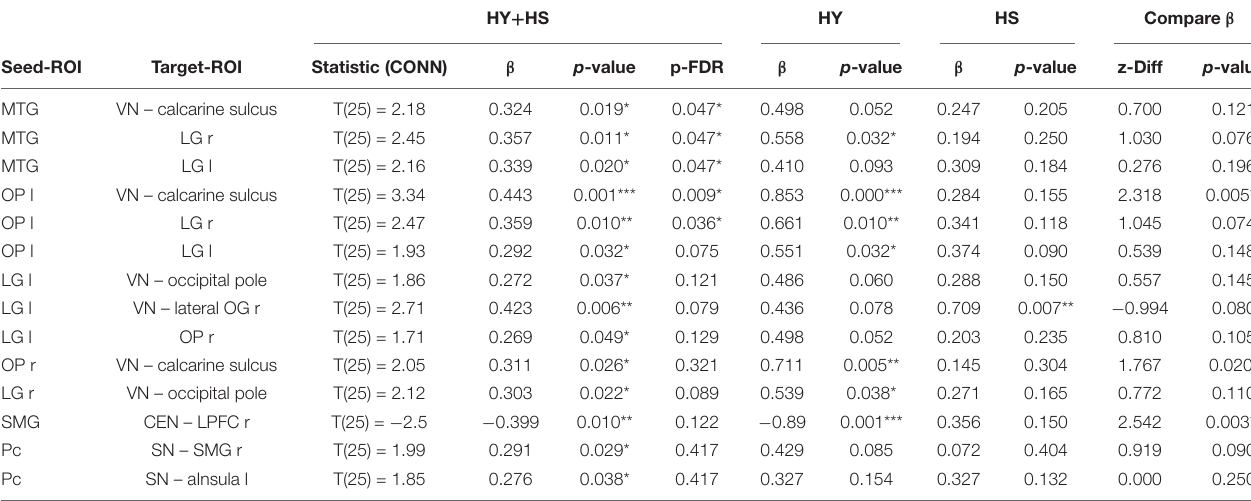
FIGURE 6 | (A) Functional connectivity (FC) between occipital, inferior temporal, and middle temporal regions during post-encoding rest predicted memory performance in the control condition ( p -FDR < 0.05). Applying a more liberal threshold ( p < 0.05), this network extends to additional nodes within occipital and temporal regions. Areas of the visual network (VN) are highlighted in yellow. (B) FC between the SMG seed as part of the salience network (SN) and a node of the central executive network (CEN) and connections between the Pc seed as a core area of the default mode network (DMN) and nodes of the SN predicted memory performance in the control condition ( p -FDR < 0.05). Areas of the DMN are highlighted in blue, areas of the CEN in red, and areas of the SN in green. fALFF-derived seeds are represented by white spheres and network ROIs by black spheres. SMG, supramarginal gyrus; Pc, precuneus; MTG, middle temporal gyrus; OP, occipital pole; LG, lingual gyrus; aInsula, anterior Insula; LPFC, lateral prefrontal cortex; CC, calcarine sulcus; l OG, lateral occipital gyrus; r, right; l, left; P, posterior. TABLE 7 | Functional connectivity during post-encoding rest predicting memory performance of HY and HS in the control condition. HY + HS HY HS Compare